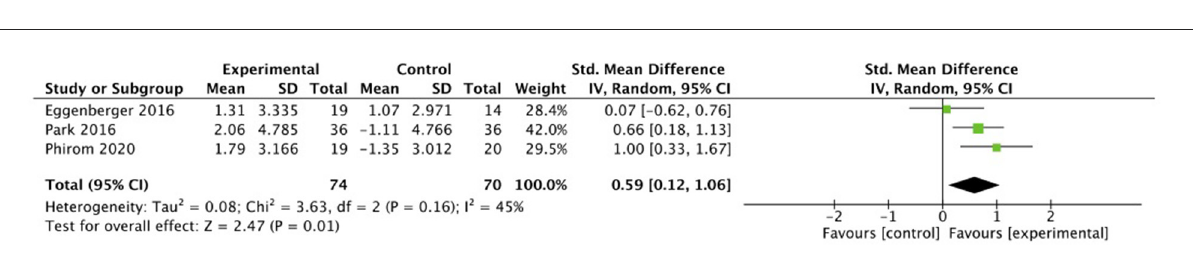
FIGURE11 Random effects meta-analysis forest plot for effectiveness of intervention on measures of MoCA cognitive performance outcomes.